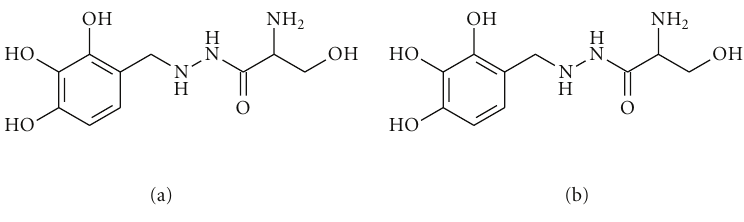
Scheme 1: Structures of (a) carbidopa and (b)